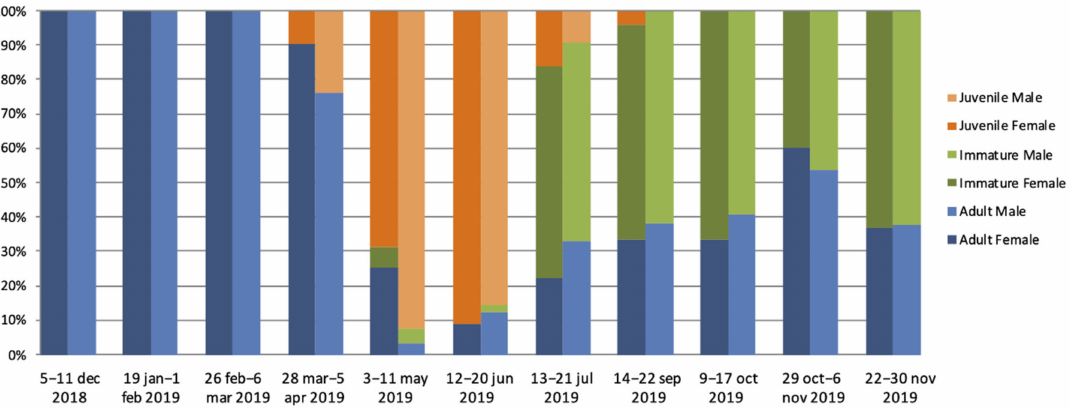
Figure 1. Age distribution per sex for Eidolon helvum bats captured at each field mission, shown as percentages. Details on numbers captured at each mission are shown in Supplementary Table S2. Table 1. Numbers and percentages of Eidolon helvum bat samples reactive with the different Ebolavirus antigens with stringent (statistical methods) and less-stringent (4 × Standard deviation of negative control samples) cut-offs as described in Methods. The assay used recombinant proteins of